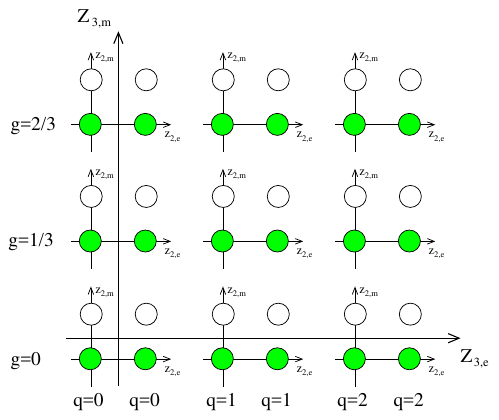
Figure 4 . (cid:0) = Z 3 . The Abelian lines are generated by ( q; g ) = (3 ; 0) and (0 ;